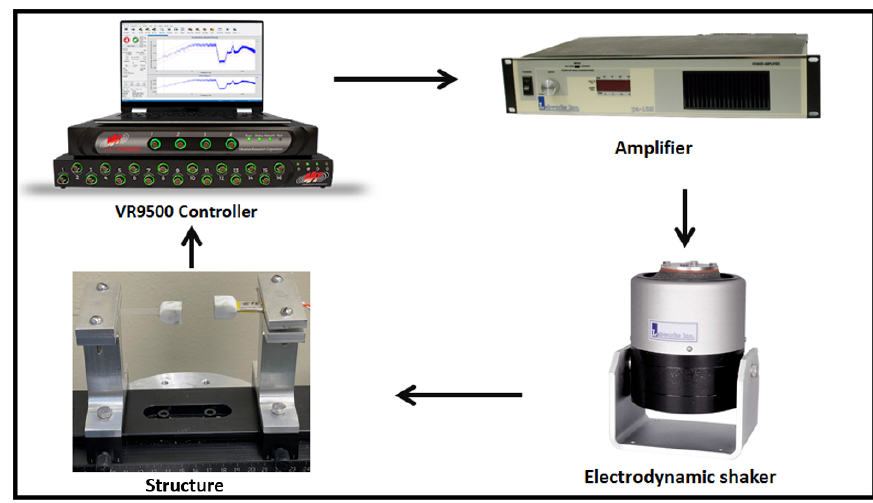
Figure 3. Experimental setup used to test the piezoelectric energy harvester frequency